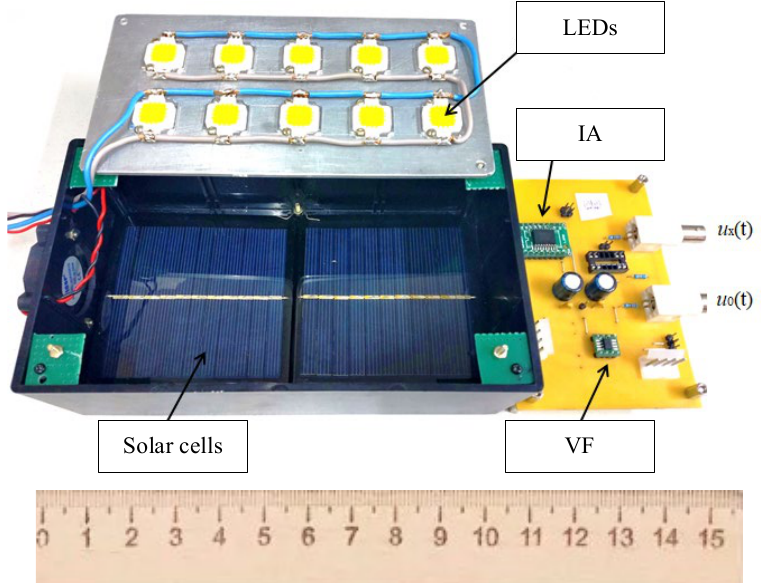
Figure 6. Prototype of differential signal recovery.